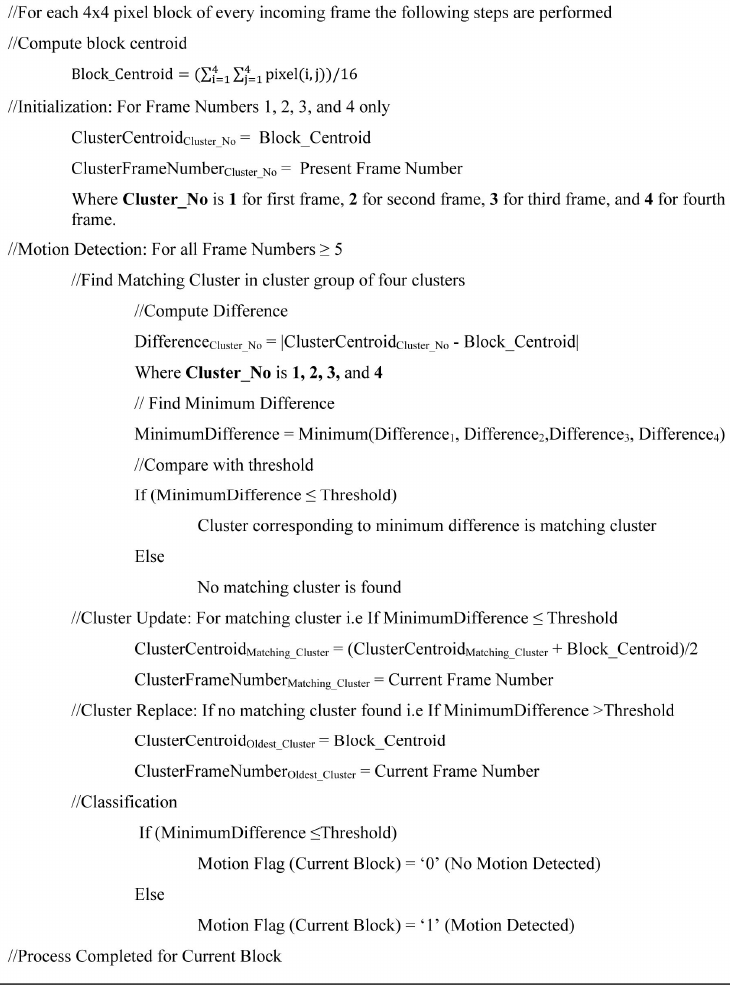
Figure 2. Pseudo-code for Clustering-based Motion Detection Scheme.